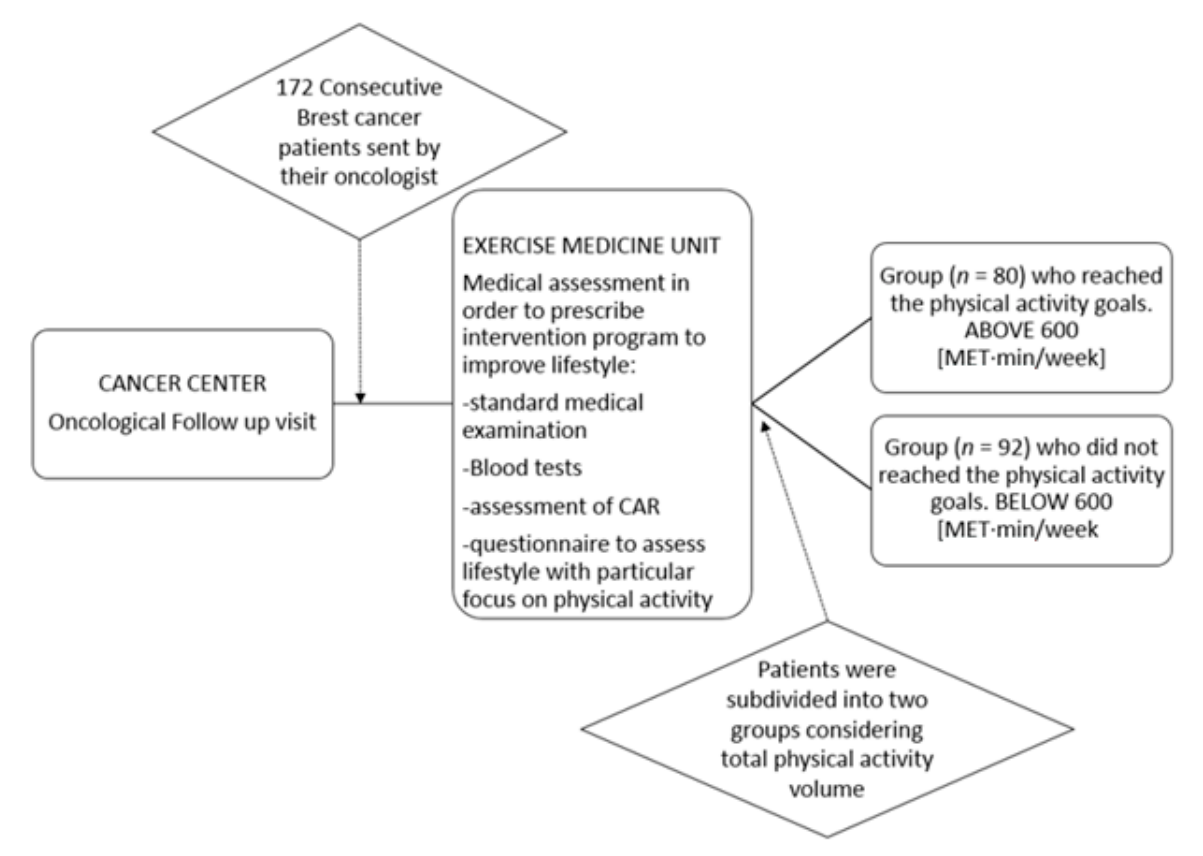
Figure 1. Flow chart: sample selection and protocol.